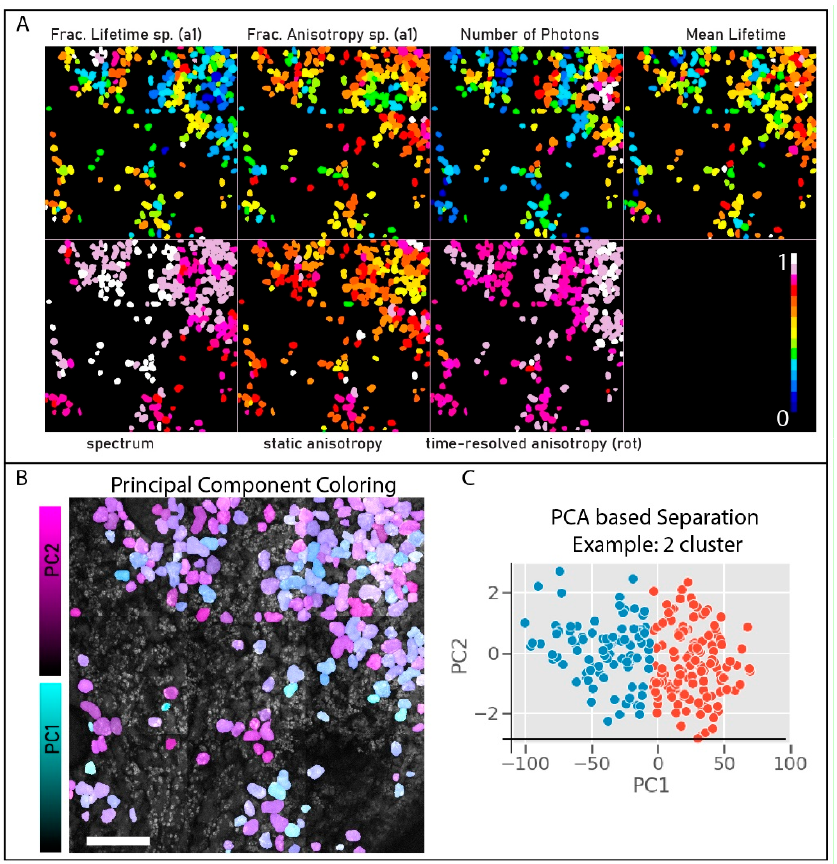
Figure 5. HDIM Computational Approach. The HDIM computation includes processing of large lifetime-histograms mapped to spectrum, and polarization read as a multidimensional data set (16 ch × 2 pol × 256) using a principal component analysis. ( A ) The seven derived inputs for PCA analysis are shown here. This includes fractional lifetime of the lowest lifetime species (a1), fractional rotational anisotropy of the lowest lifetime species(a1), intensity, mean fluorescence lifetime, spectral-peak wavelengths, static anisotropy values and time-resolved mean rotational time. This analysis reduces the data into three components, often painted in RGB. In this dataset, the derived parameters are fed into the PCA analysis, and only two components are derived, PC1, and PC2. The two components are painted in cyan and magenta and overlaid on the intensity image in panel ( B ). The two components were analyzed by multiple cluster separation using a k-means separation. A 2-component separation is shown in panel ( C ) as an example.